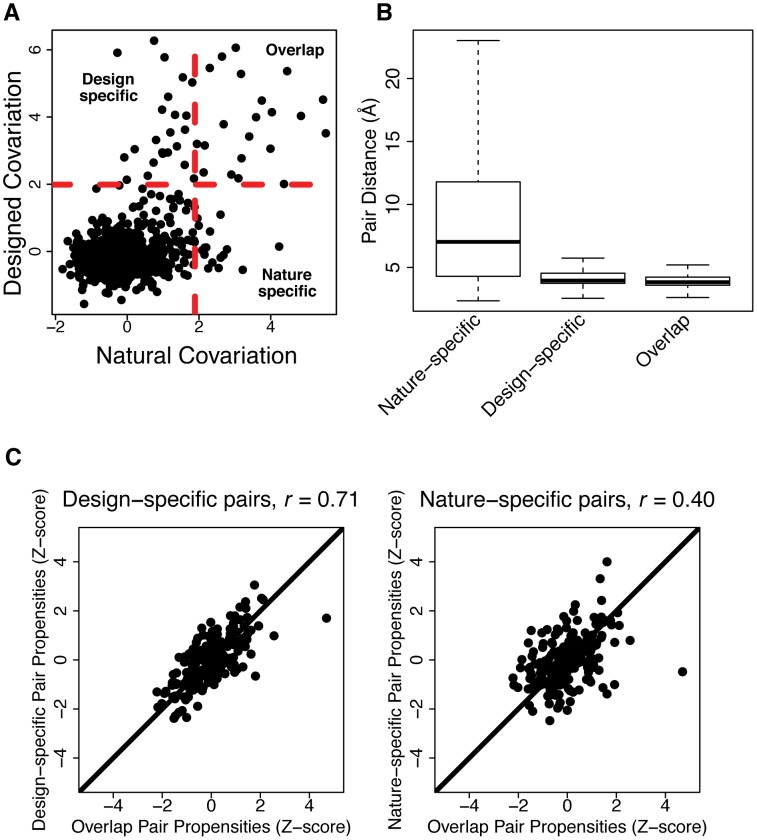
Distinguishing features of natural and designed covarying pairs.A) Example comparison of natural and designed covariation for an individual protein domain (SH3 domain). Each dot represents an amino acid pair. Dashed red lines indicate the thresholds used to identify pairs as highly covarying (two standard deviations above the mean). The indicated quadrants contain the design-specific, overlap and nature-specific pairs, respectively. B) Box plot of distances between amino acid pairs in the nature-specific, design-specific and overlap sets. Pair distances are measured as the minimum distance between heavy-atoms of two amino acids in the representative crystal structure of the domain. C) Correlation of amino acid pair propensity Z-scores between different sets of covarying pairs. The left plot shows the correlation between design-specific and overlap pairs and the right plot shows the correlation between nature-specific and overlap pairs. A Pearson correlation coefficient (r) is shown for each plot.